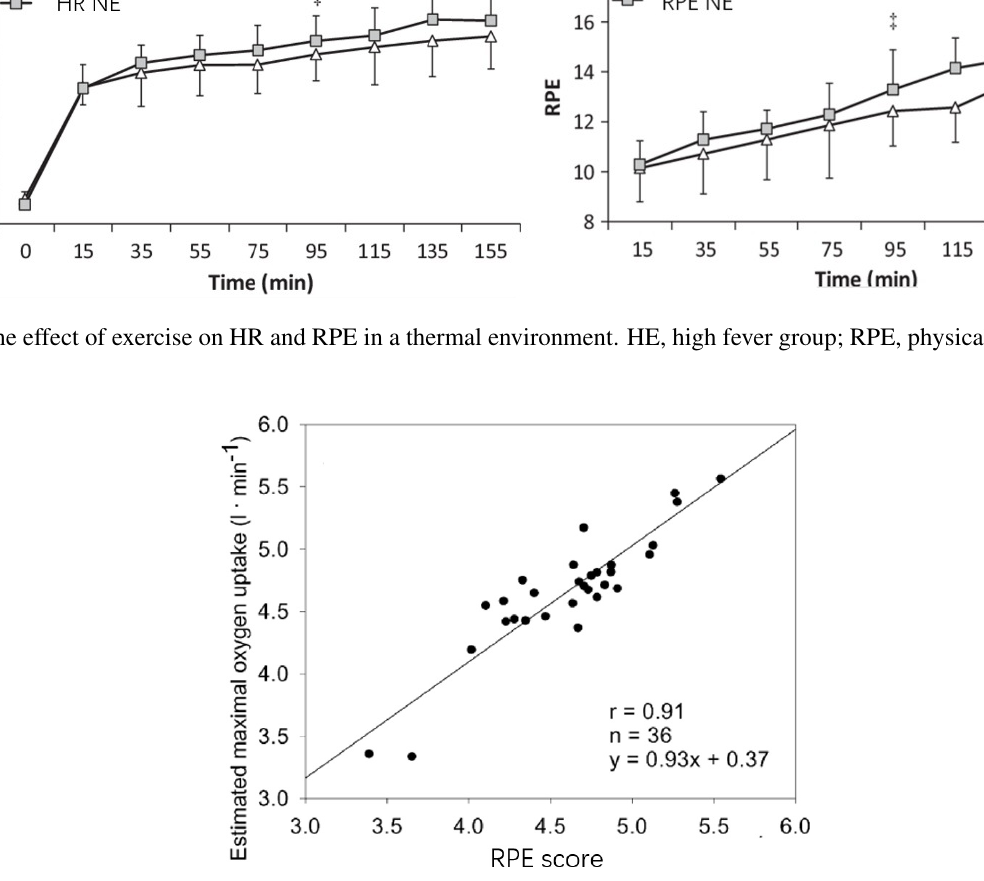
Fig. 2 Scatter plot of HR and RPE in a thermal environment. RPE, physical performance